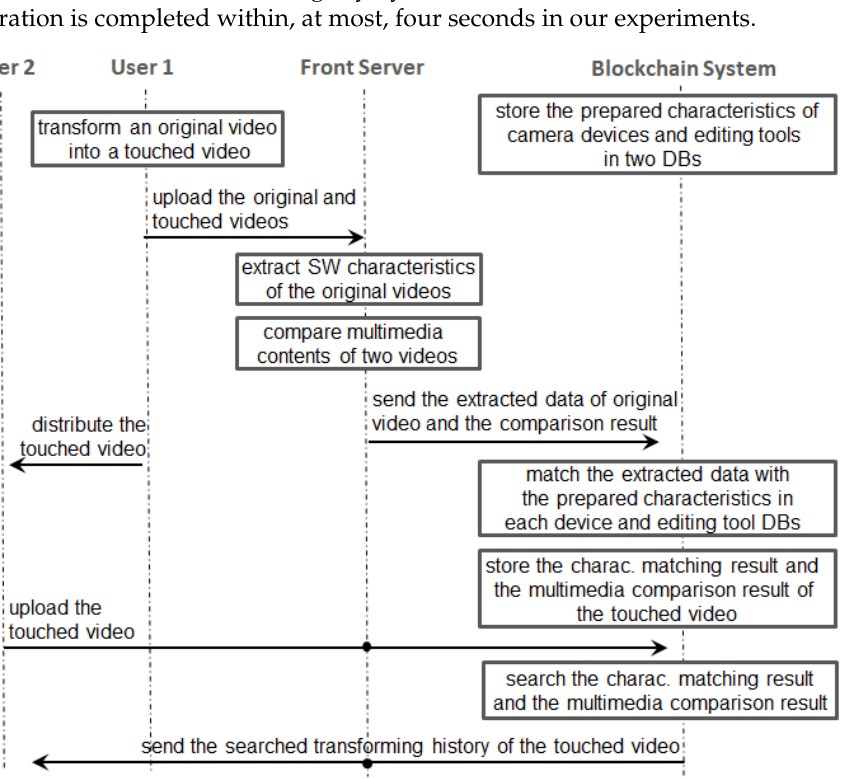
Figure 1. Overall procedure to trace integrity preservation for retouched but non-tampered video